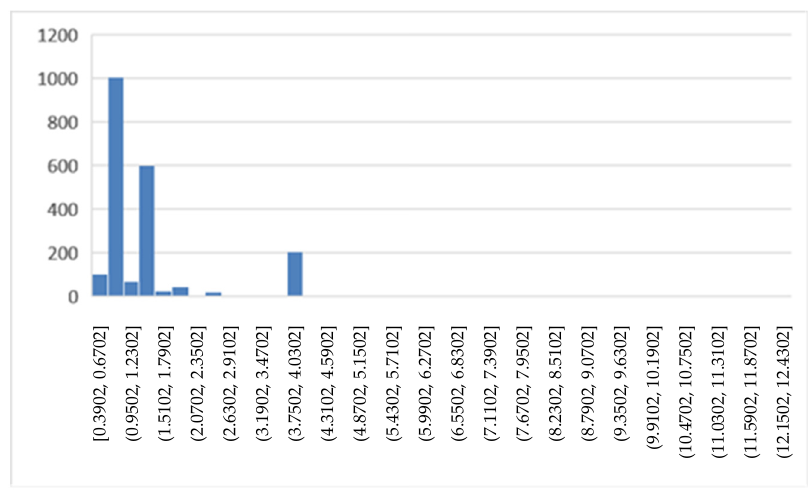
Figure 8. DRG relative weight (2020, 2021).